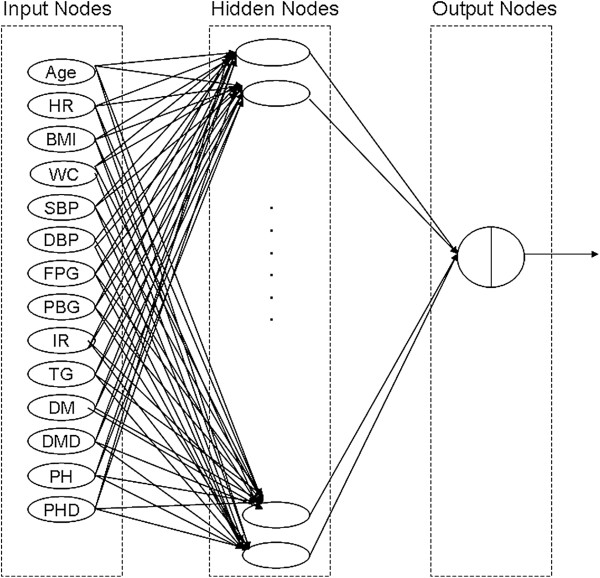
Artificial network model showing input variables (nodes), hidden nodes, and connection weights with output node for data on CA dysfunction. The ANN model including 14 input nodes, 18 hidden nodes and 1 output node. BMI- Body mass index, WC-waist circumference, SBP- systolic blood pressure, DBP- diastolic blood pressure, FPG- fasting plasma glucose, PBG- plasma blood glucose, IR-insulin resistance, TG- triglyceride, UA- uric acid, HR-heart rate, PH- Hypertension, DM- Diabetes, PHD- Hypertension duration, DMD- Diabetes duration.